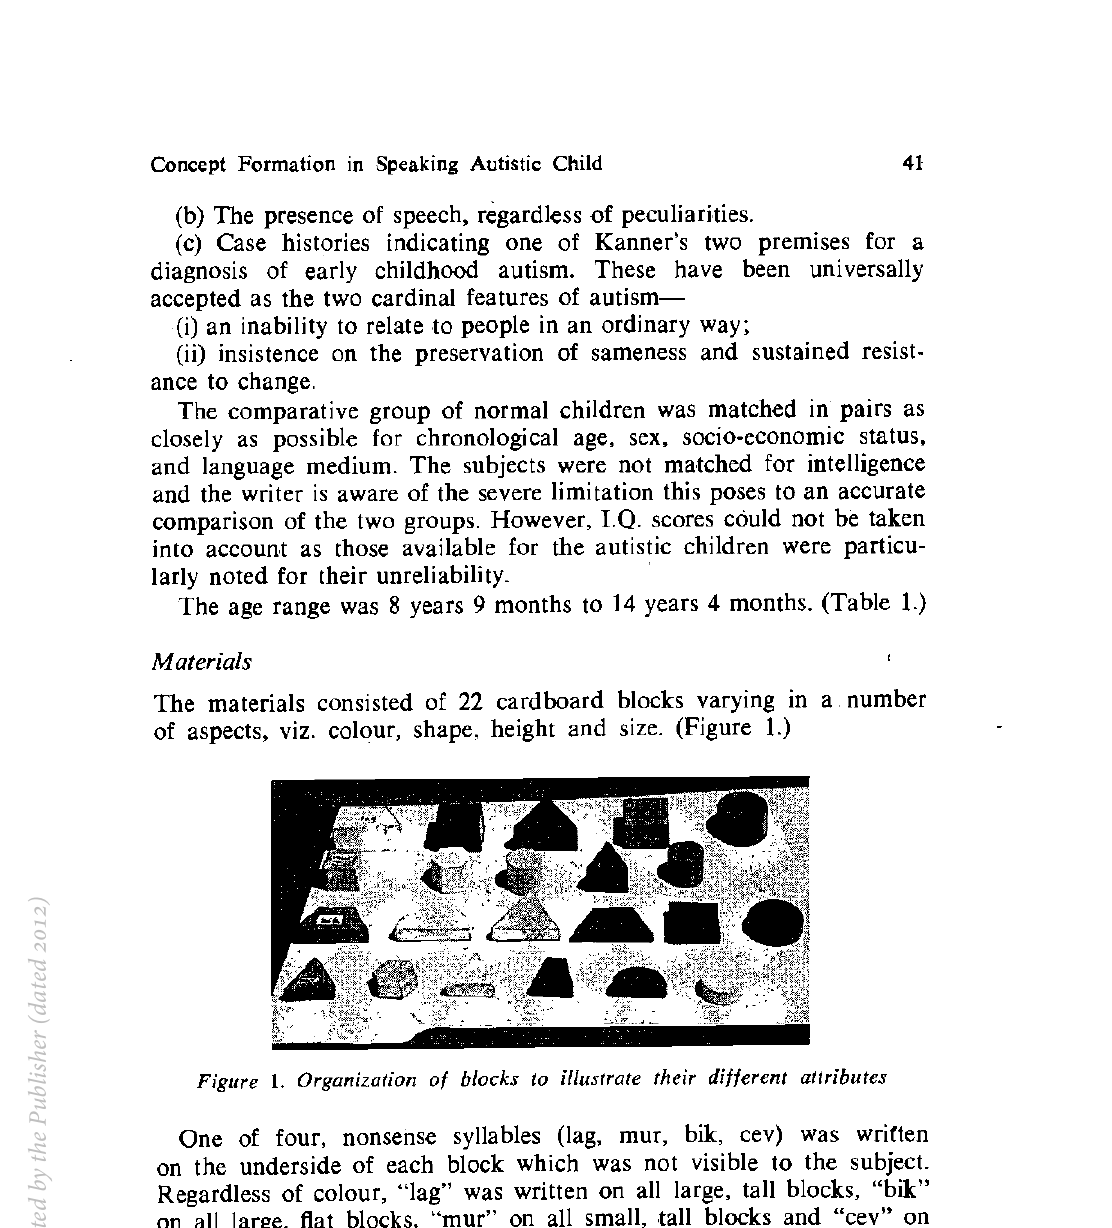
Figure 1. Organization of blocks to illustrate their different